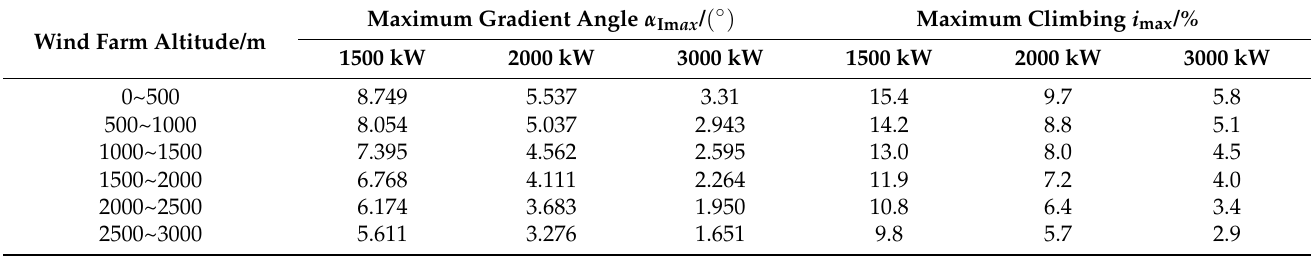
Table 3. Maximum climbing angle and maximum climbing value of typical vehicle models used by units of different